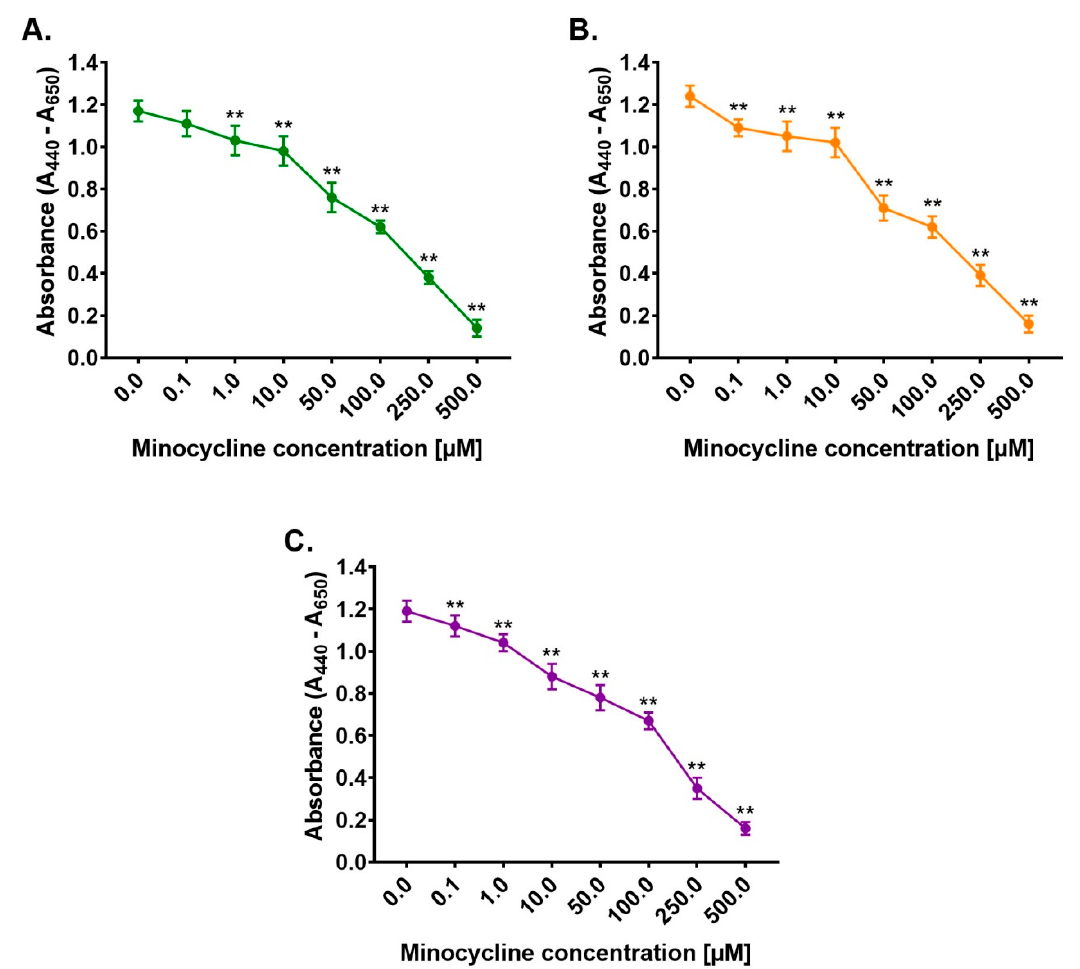
Figure 1. Minocycline inhibits proliferation of human normal melanocytes ( A ) non-irradiated ( B ) exposed to UVA (2 J/cm 2 ) and ( C ) UVB (10 mJ/cm 2 ) radiation. Cells were incubated with minocycline in concentrations ranging from 0.1 µ M to 500 µ M. Mean values ± SD from three independent experiments are presented. ** p < 0.005.